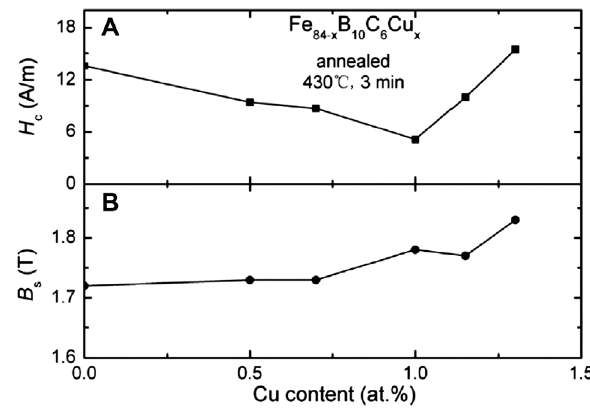
Figure 2 Cu content dependence of (A) coercive force and (B) satu- ration magnetic flux density (Fang et al. [10], Copyright AIP 2011).